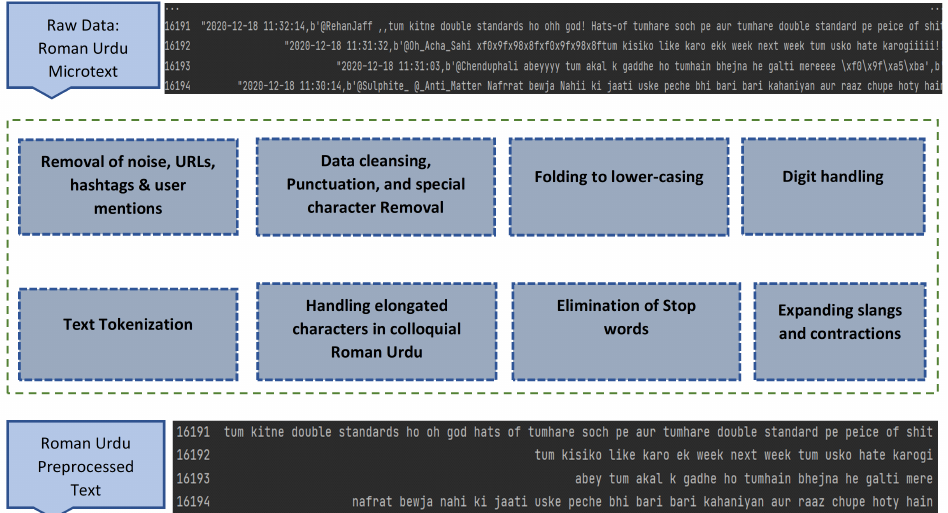
Figure 2. Text preprocessing steps on Colloquial Roman Urdu micro text.